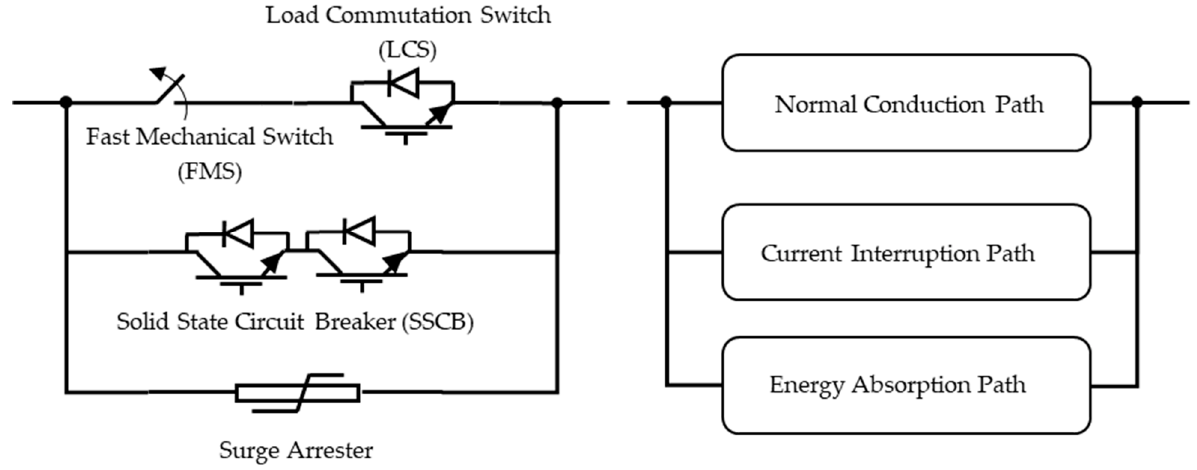
Figure 1. Schematic of a modular hybrid IGBT DC breaker.